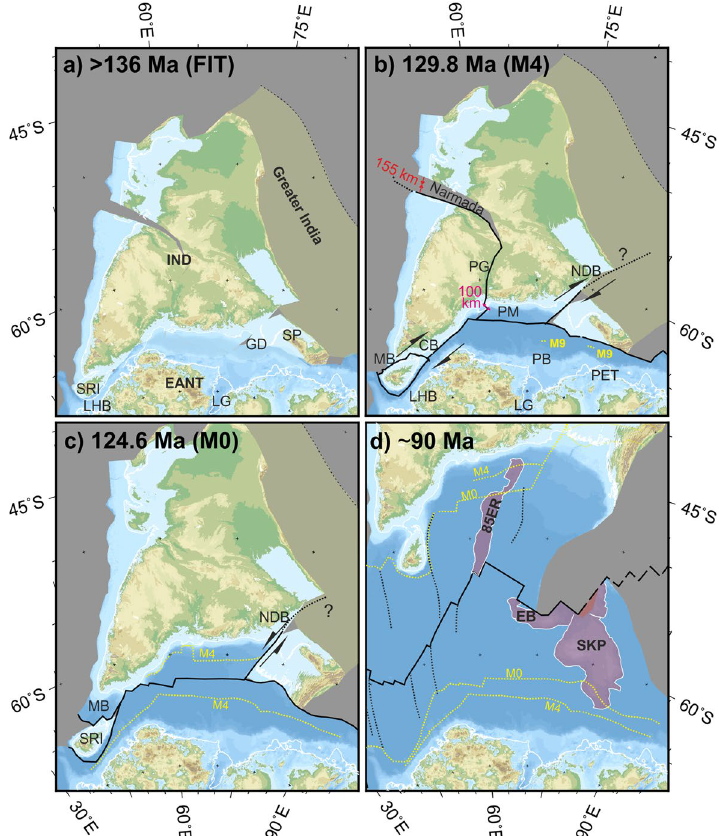
Figure 5. Revised plate kinematic reconstructions. Maps: Generic Mapping Tools 36 . Grey fill: lost area (e.g. Greater India, shortened and/or subducted since Paleogene). Background: present-day topography and bathymetry 33 (from https:// topex. ucsd. edu/ cgi- bin/ get_ data. cgi) and subglacial topography in Antarctica 34 . White outlines: present-day coastlines. Black lines: active plate boundaries. Yellow dotted lines: labelled magnetic isochrons. ( a ) Initial INDSRI-Antarctic fit. Abbreviations: EANT-East Antarctica; GD- Upper Ganges Delta; LG-Lambert Graben; LHB-Lützow Holm Bay; IND-India; SP-Shillong Plateau; SRI-Sri Lanka. ( b ) Chron M4 (~ 130 Ma) reconstruction. Differing rates of early (post-M9/ ~ 133.5 Ma) seafloor spreading in Prydz Bay (PB) and Princess Elizabeth Trough (PET) and slow oblique continental extension in LHB are accommodated by deformation within the Pranhita–Godavari (PG), northern Damodar (NDB), and eastern offshore Palar Margin, Cauvery, and Mannar basins (PM, CB, MB). Red text: maximum estimates of this deformation. ( c ) Reconstruction at chron M0 (~ 125 Ma). New seafloor may have formed within MB. Intracontinental motion within India had ceased except along the NDB, where the sense of strike-slip had reversed. ( d ) Reconstruction at 90 Ma. The Shillong Plateau (labelled SP in a ) reached its present-day location with respect to India by